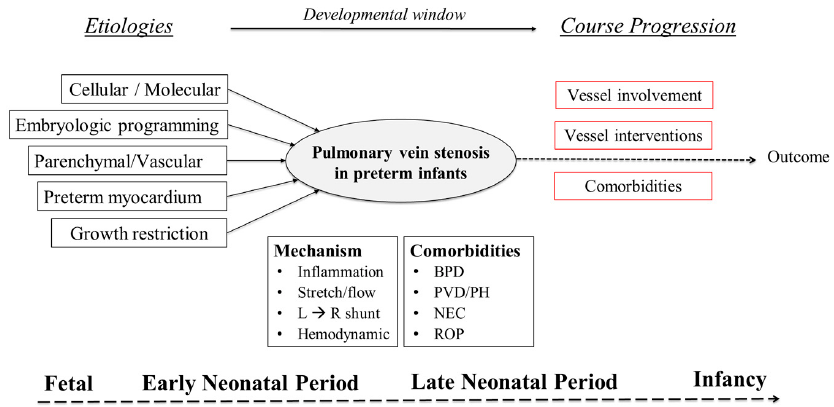
Figure 5. Preterm infants are a unique population of PVS: course progression.